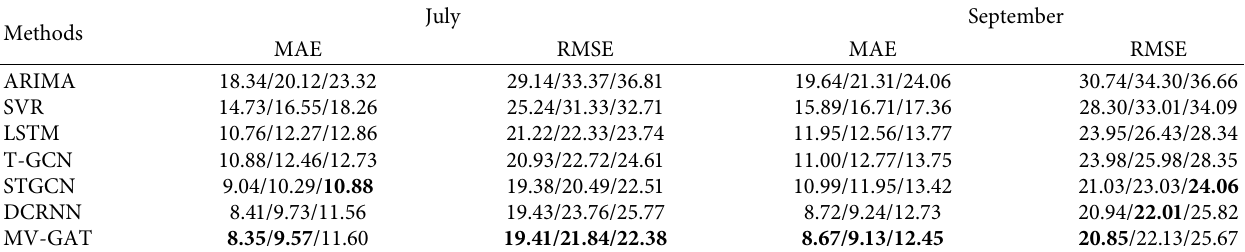
Table 1: Accuracy results of rail passenger flow prediction experiment.